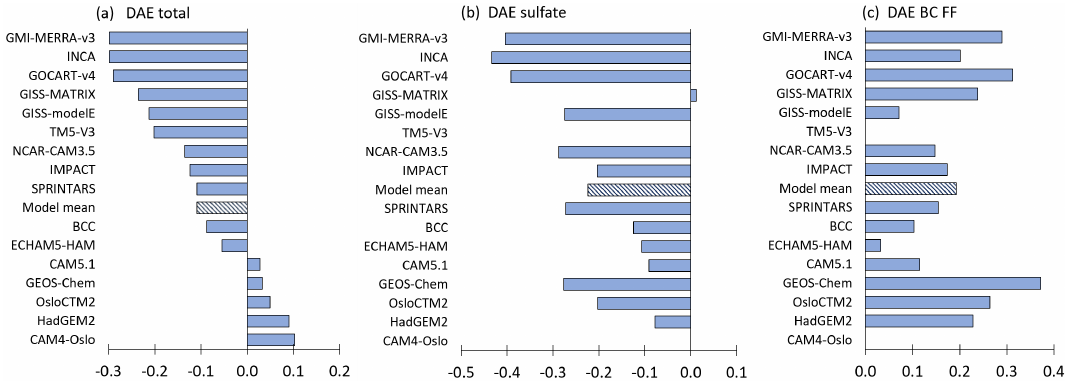
Figure 15. Arctic annual mean DAE (in Wm − 2 ) for the AeroCom Phase II models, total (a) , sulfate (b) , BC FF (c) . The striped bar is the model mean. TM5-V3 and CM4-Oslo have reported the total only.